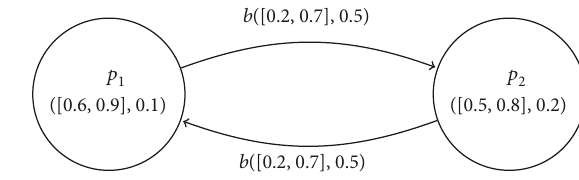
Figure 7: ̂𝜓 is not a good subsystem.